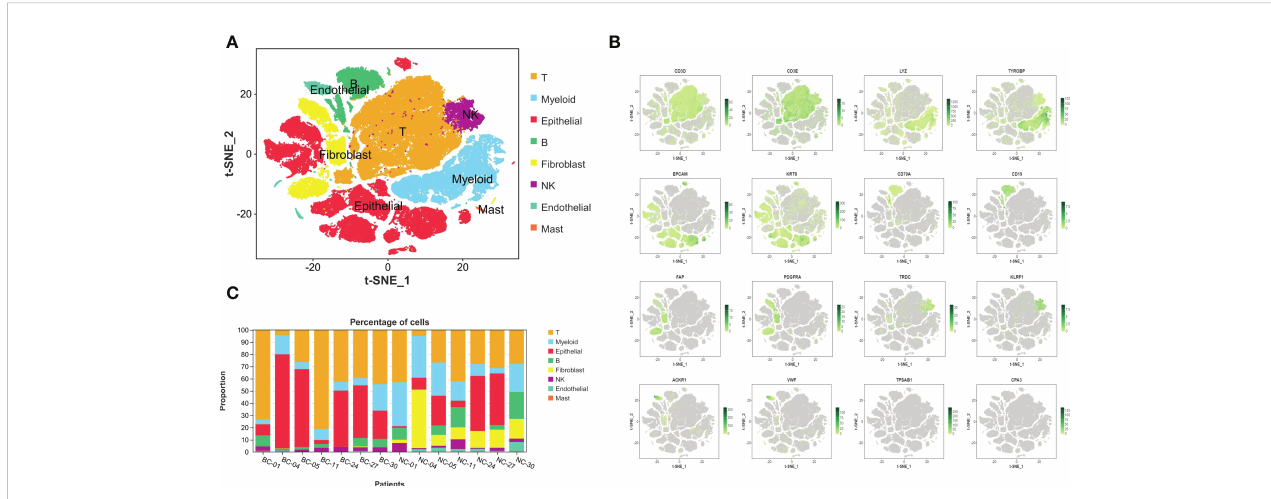
FIGURE 1 The complex composition of the tumor microenvironment in bladder cancer and corresponding normal tissues adjacent to cancer. (A) Eight kinds of basic in fi ltrated cell types in TME. (B) The expression and distribution of identi fi cation markers: T cells: CD3D and CD3E, myeloid cells: LYZ and TYROBP, epithelial cells: EPCAM and KRT8, B cells: CD79A and CD19, fi broblast cells: FAP and PDGFRA, NK cells: TRDC and KLRF1, endothelial cells: ACKR1 and VWF, and mast cells: TPSAB1 and CPA3. (C) Varying constituent ratio of in fi ltrated cell types in different BC and corresponding normal tissues. TME, tumor microenvironment; BC, bladder